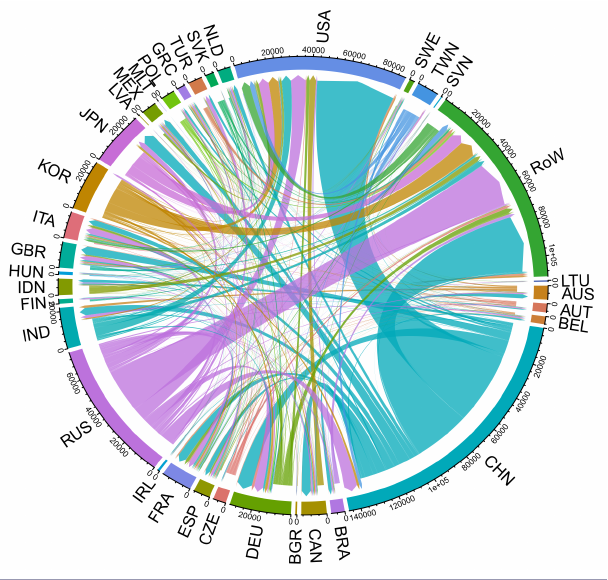
Fig. 5 . Upstream and downstream spillovers of valued added exports (VAX) by country. Countries are sorted from top to bottom by upstream spillover. Country codes are specified in